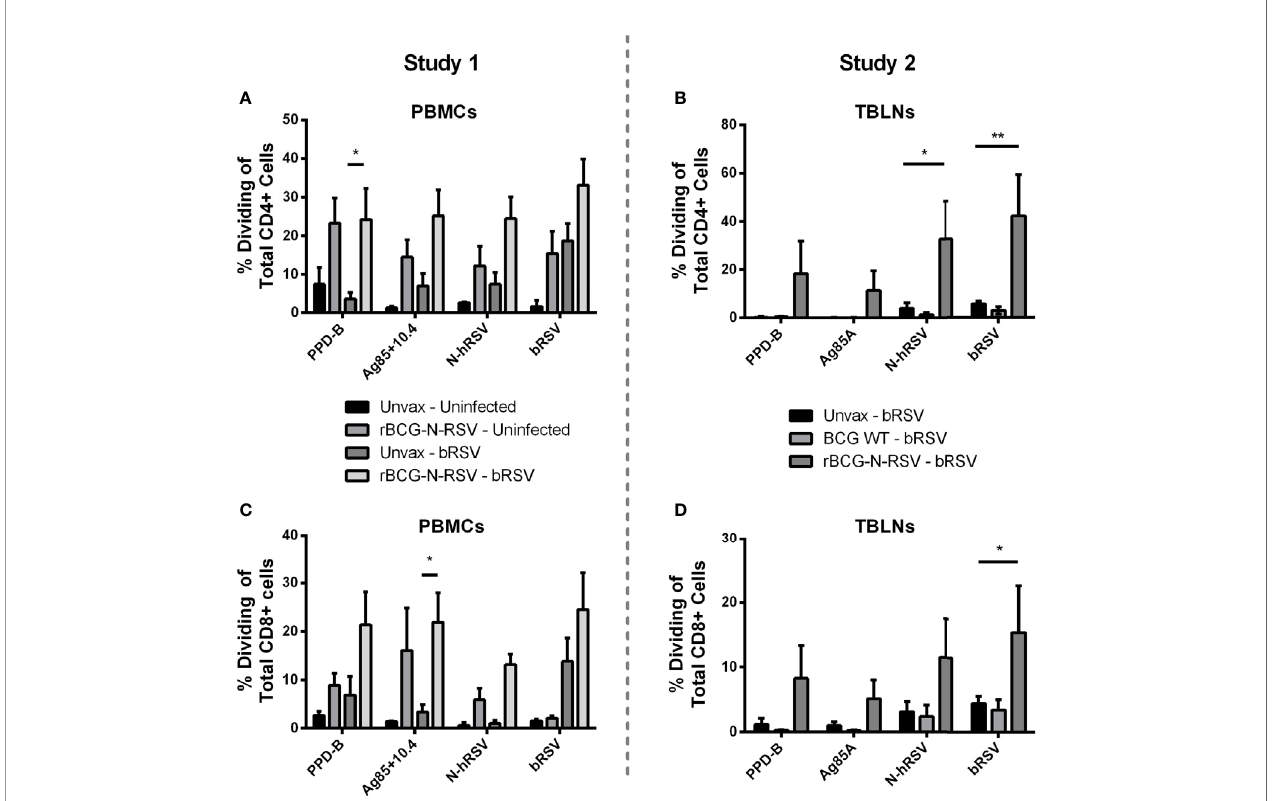
FIGURE 4 | Vaccination with rBCG-N-hRSV elicits antigen-speci fi c CD4 and CD8 T cell proliferative responses. (A, C) Study 1 PBMCs and (B, D) Study 2 Tracheobronchial lymph node cells (TBLNs) were isolated on day 7 after infection, labeled with Cell Trace Violet, and restimulated in vitro with PPD-B, Ag85A/ TB10.4, N-hRSV or bRSV strain 375. Mock stimulated cultures were used as negative controls. ConA stimulated cultures were used as positive controls (not shown). Six days later, (A, B) CD4 + T and (C, D) CD8 + T cell proliferation, as measured by dilution of the Cell Trace dye, was analyzed by fl ow cytometry. Data represented as mean ± SEM *p<0.05 **p<0.01 as determined by 2-way ANOVA and Sidak ’ s multiple comparisons